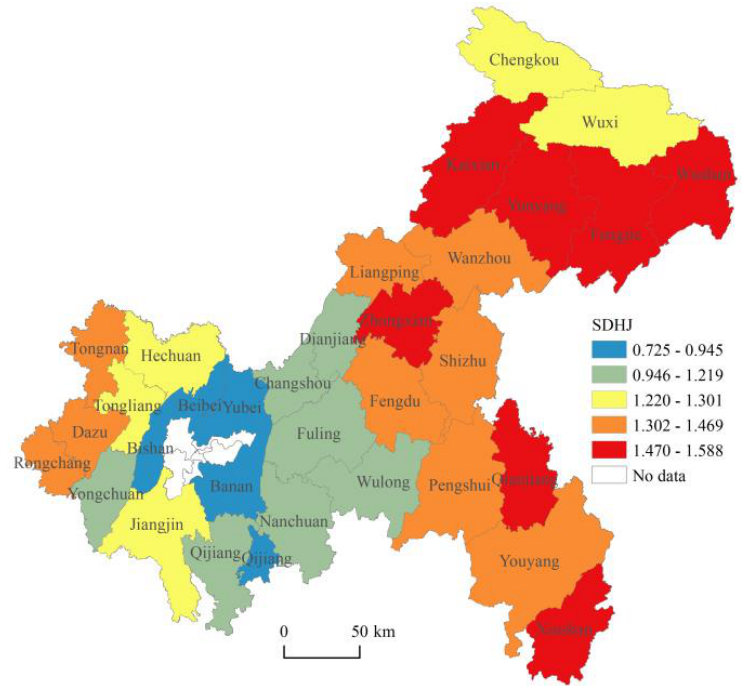
Figure 3. The spatial patterns of SDHJ in Chongqing.